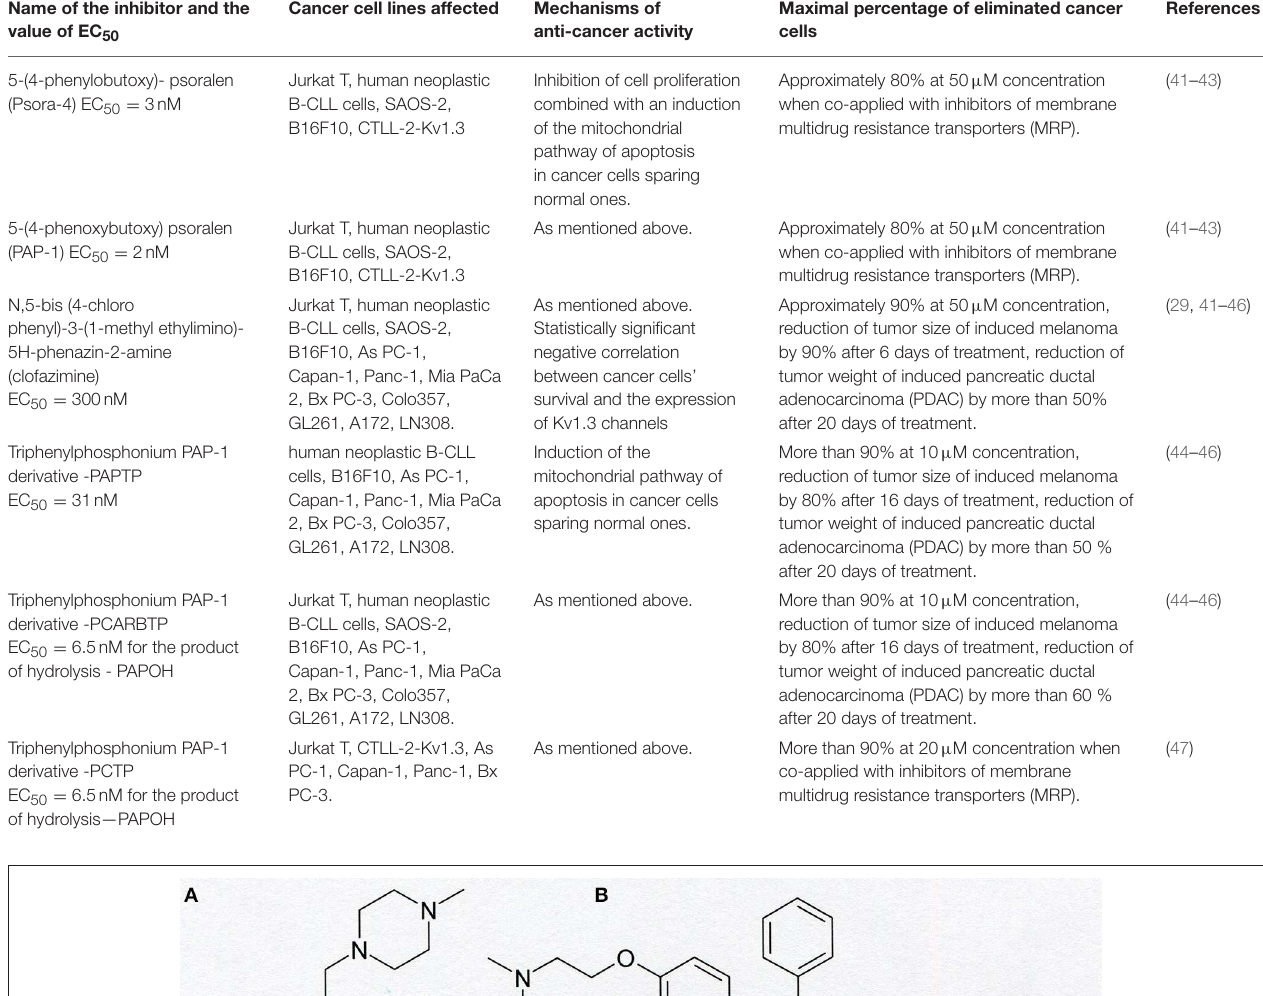
TABLE 2 | Anti-cancer activities of small-molecule membrane-permeant specific inhibitors of Kv1.3 channels. Name of the inhibitor and the value of EC 50